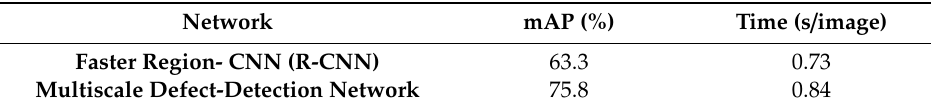
Table 2. Performance comparison with different networks.